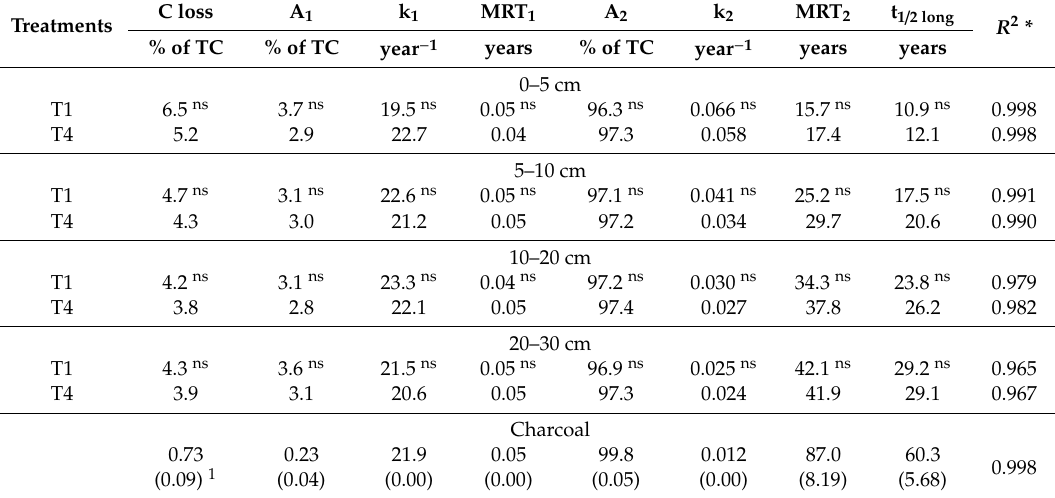
Values represent means of four replicates, and ns indicates t-test results of p > 0.10. 1 Values within parentheses refer to the standard deviation of the charcoal data. * Coe ffi cient of determination of the fit correlating the cumulative